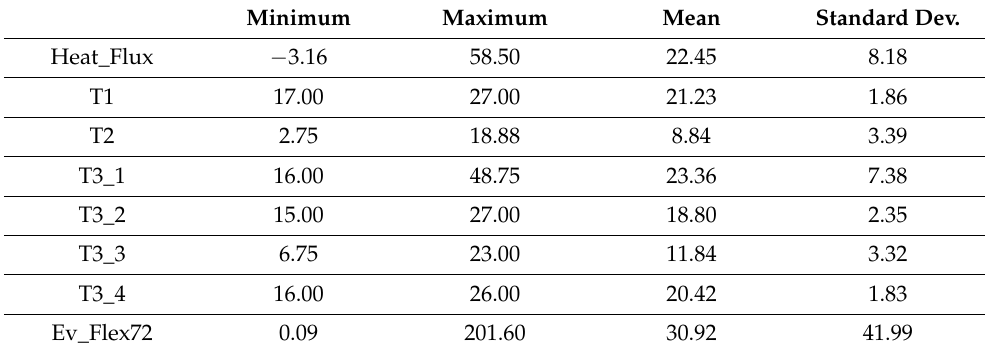
Table 1. Statistical summary of the data-set. Minimum Maximum Standard